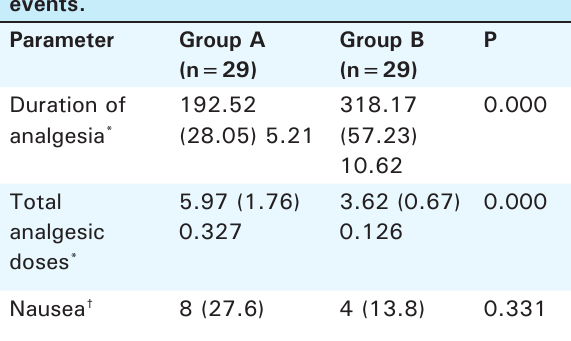
Table 4. Duration of analgesia and postoperative